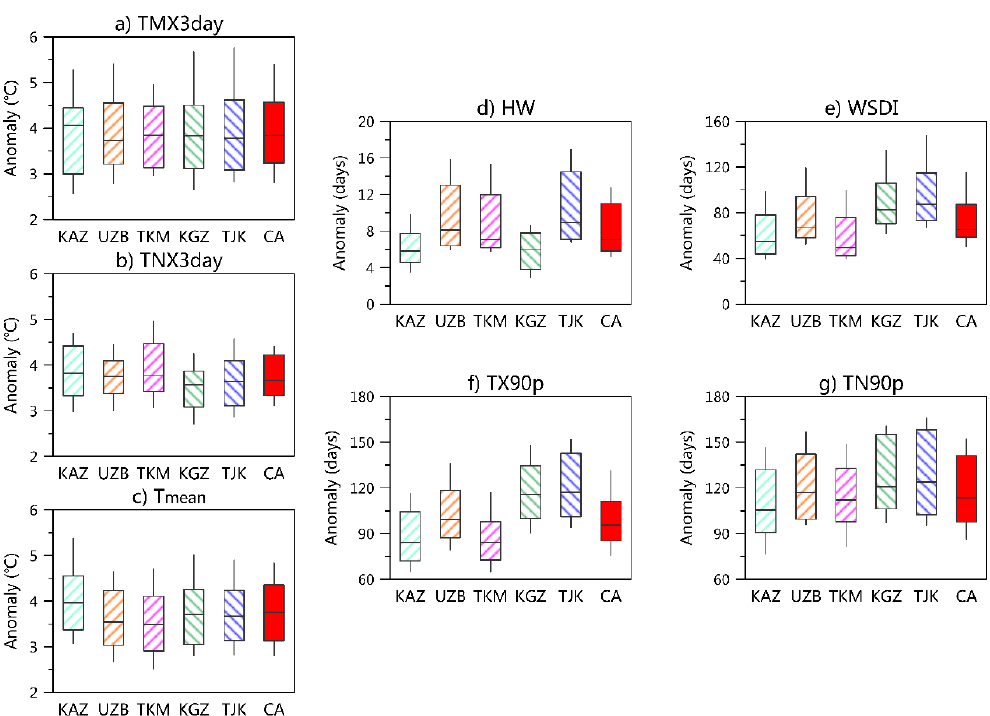
Figure 5. Population density-weighted average differences among the INDC-pledge scenario and the present level of the ( a ) TMX3day, ( b ) TNx3day, ( c ) annual mean temperature, ( d ) HW, ( e ) WSDI, ( f ) TX90p, and ( g ) TN90p in Central Asia and its subregions. The box-whisker plots show the multi-model ensemble 10th, 25th, 50th, 75th, and 90th intervals. The population density-weighted average was estimated based on the population prediction for 2100 under the socioeconomic pathway 2 (SSP2) scenario. The results of regional average refer to Figure S3. KAZ = Kazakhstan; UZB = Uzbekistan, TKM = Turkmenistan, KGZ = Kyrgyzstan, and TJK = Tajikistan.